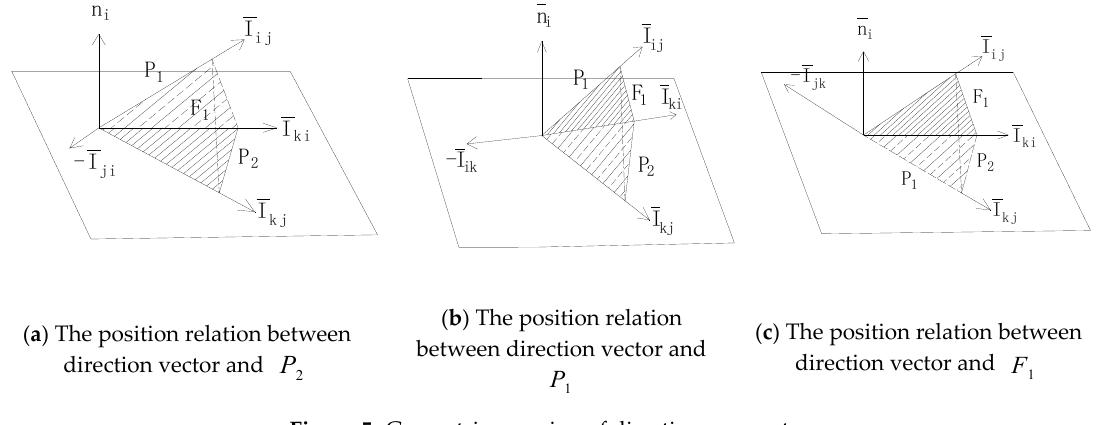
Figure 5. Geometric meaning of direction parameter.